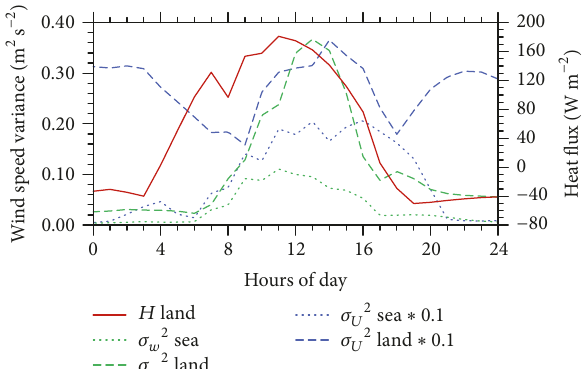
Figure 8: Time evolution of heat flux ( 𝐻 ), variance of cross-roll vertical wind ( 𝜎 2 𝑤 ), and horizontal wind speed ( 𝜎 2 𝑈 ) on 25 May 2011 from model simulations. Dashed lines show values over land and dotted lines show values over